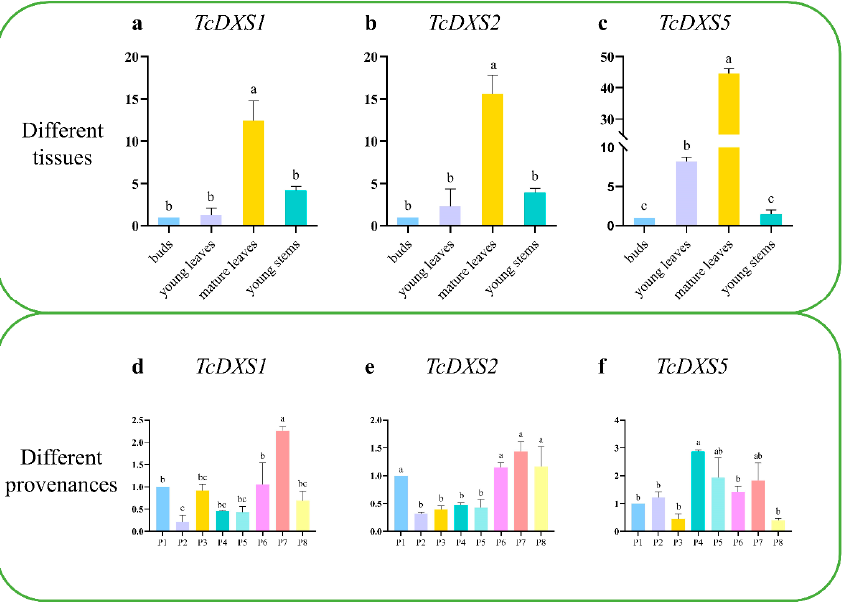
Figure 8. Expression of TcDXS1 , TcDXS2 and TcDXS5 genes in different tissues and different provenances. The data represent the mean of three independent biological replicates relative to buds and P1 (Pupiao Yunnan), respectively. Different letters above the bars represent statistically significant differences ( p < 0.05) detected by a one-way ANOVA test. ( a ) Expression of TcDXS1 gene in different tissues. ( b ) Expression of TcDXS2 gene in different tissues. ( c ) Expression of TcDXS5 gene in different tissues. ( d ) Expression of TcDXS5 gene in different provenances. ( e ) Expression of TcDXS2 gene in different provenances. ( f ) Expression of TcDXS5 gene in different provenances.